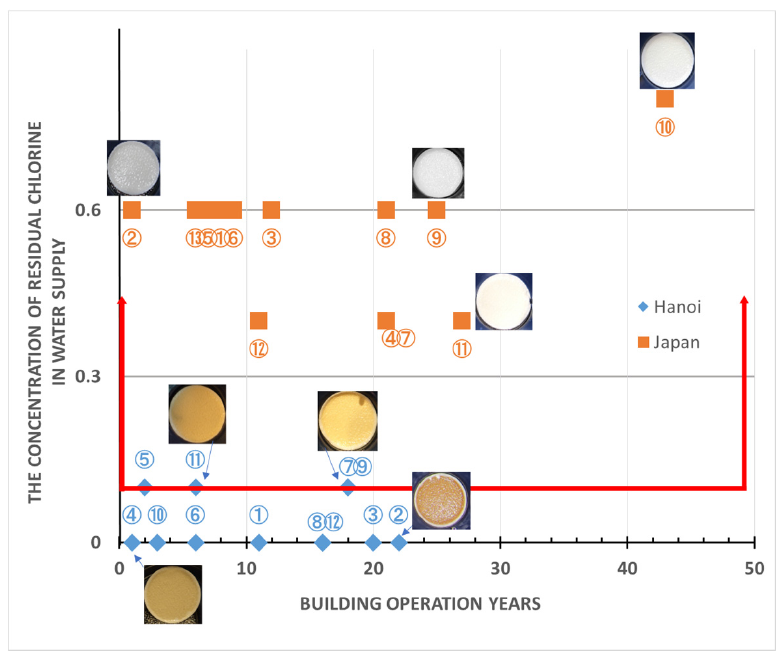
Figure 1. Residual effective chlorine concentration in tap water supplied in hotel rooms.